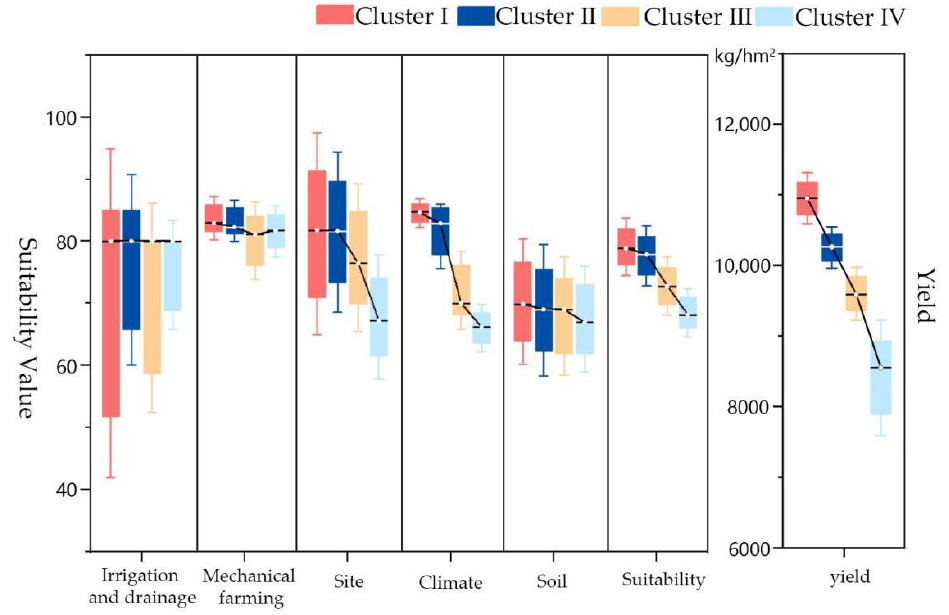
Figure 7. Multidimensional environmental suitability characteristics of the four clusters.